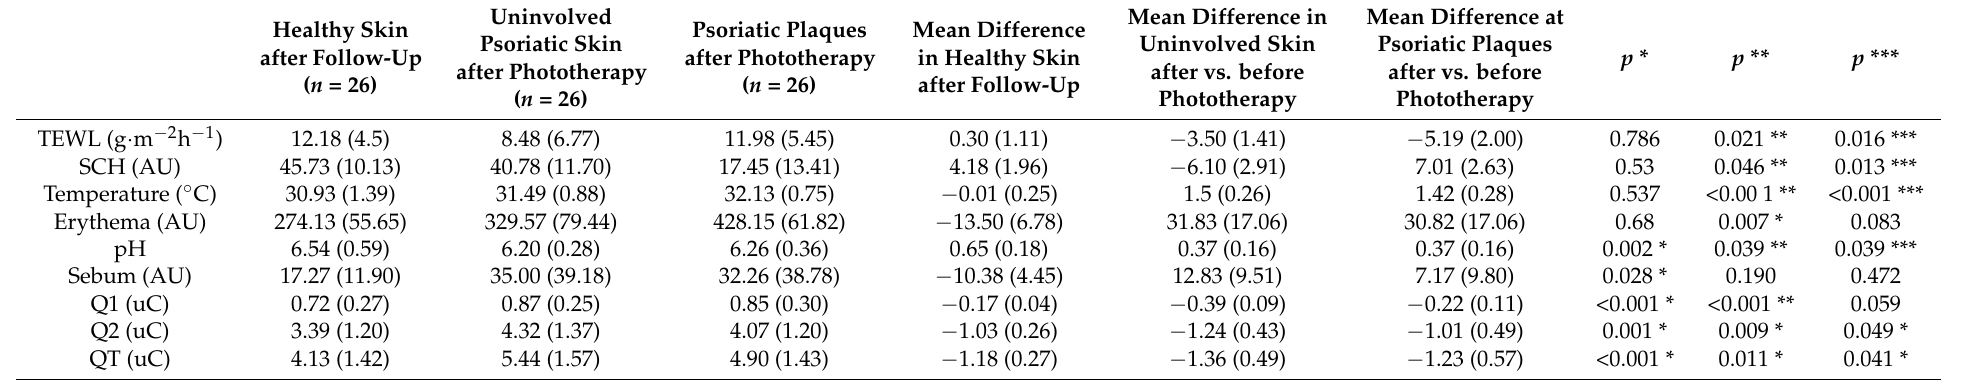
Table 3. Homeostasis parameters in healthy skin, uninvolved psoriatic skin, and psoriatic plaques after fifteen phototherapy sessions. Healthy